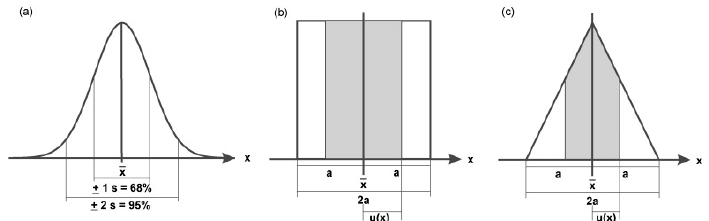
Figure 2. Statistical distribution functions, used within the Guide to the Expression of Uncertainty in Measurement (GUM) approach to model effects of Type A and Type B, from [8]. ( a ) Normal distribution, ( b ) uniform distribution and ( c ) rectangular distribution.